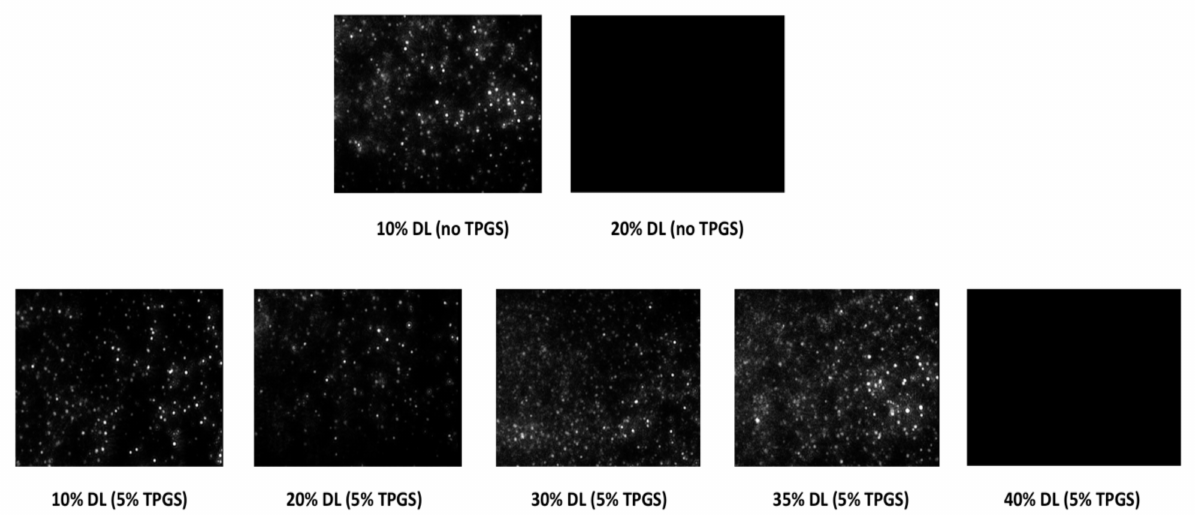
Figure 8. NTA scattering images of solutions obtained after dissolution of felodipine-PVPVA ASDs without TPGS (upper panel) and with 5% TPGS (lower panel). The bright spots indicate the presence of light scattering species where the field of view is 100 by 80 µ